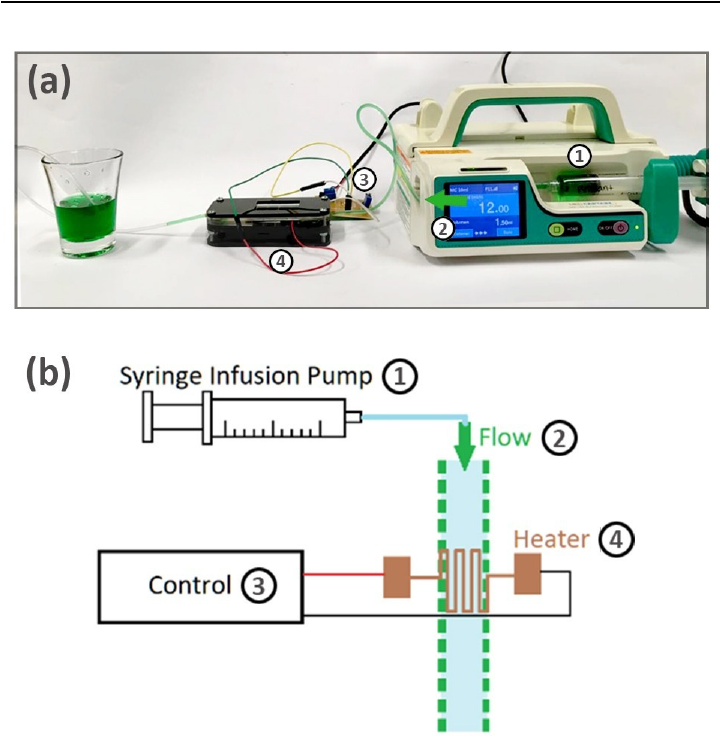
Figure 3. Test assembly with a thermographic camera: ( a ) schematic; ( b ) photograph.